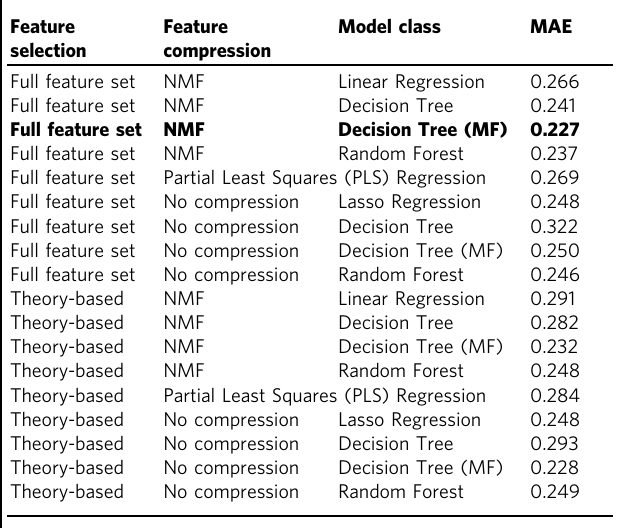
Table 1 LOOCV performance of the different